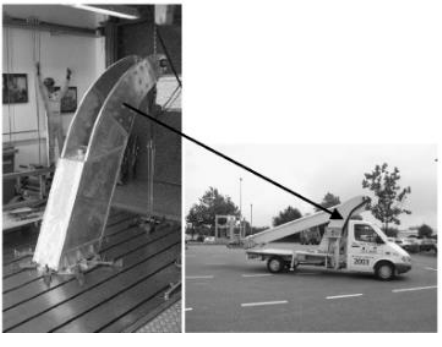
Figure 1: Lifting arm made from AFS sandwich panels [5]